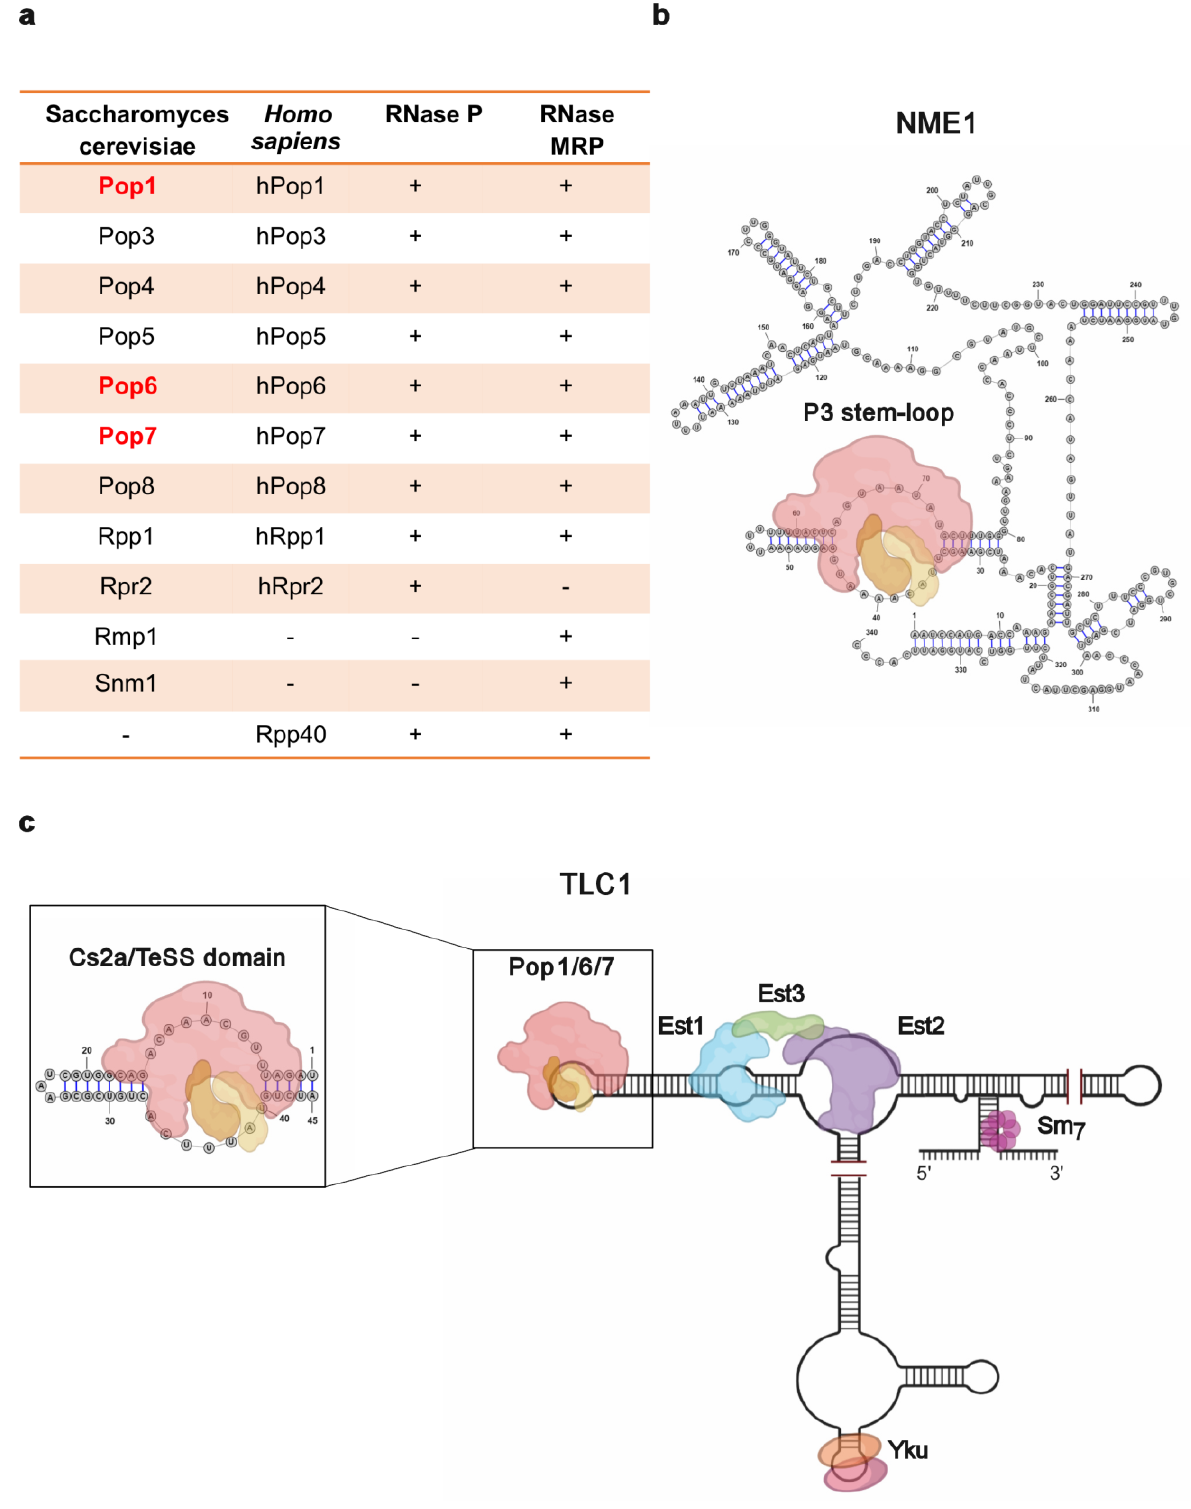
251 Microbial Cell | SEPTEMBER 2020 | Vol. 7 No. 9